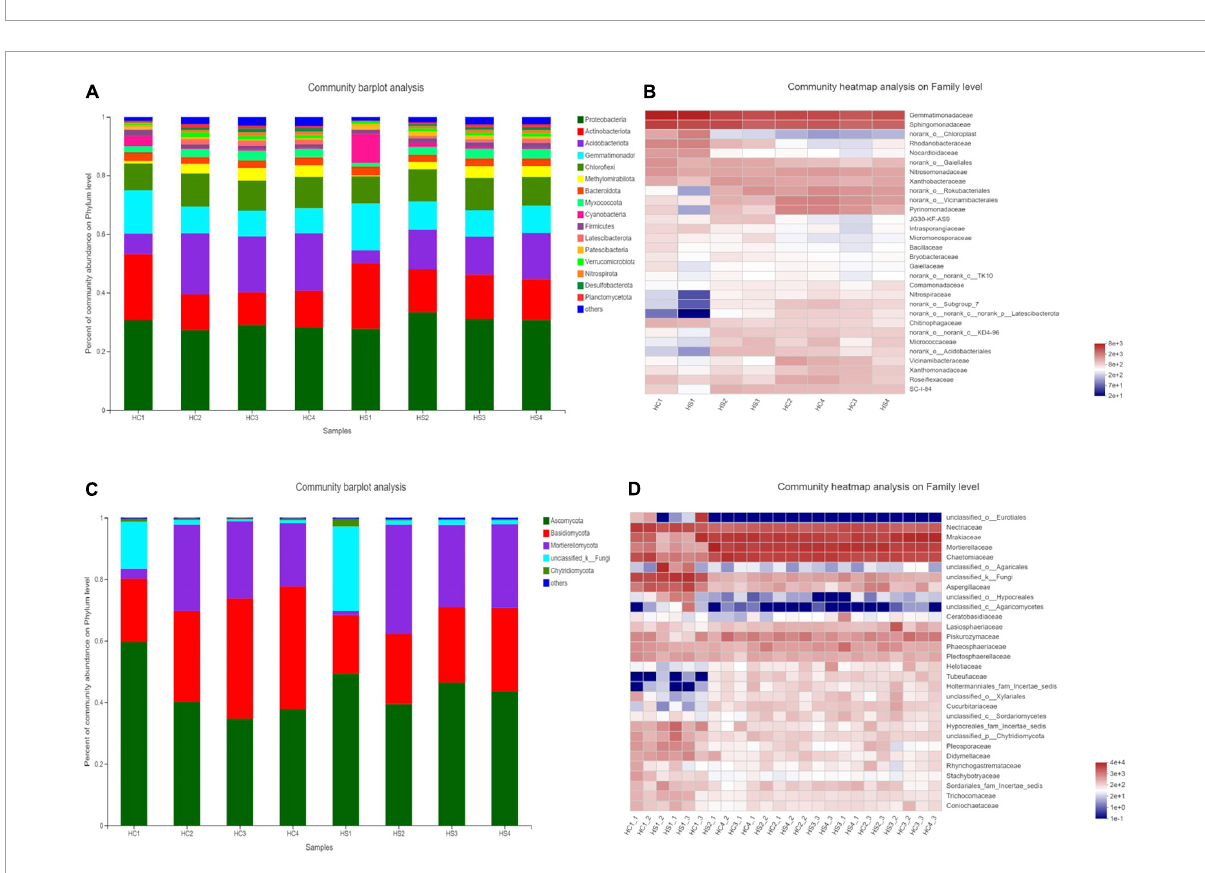
FIGURE4 Composition and structure of the microbial community in soil samples from different soil layers in phylum level classification [panel (A) for bacteria; panel (B) for fungi]. Heatmap of microbial community abundance in family level classification [panel (C) for bacteria; panel (D) for